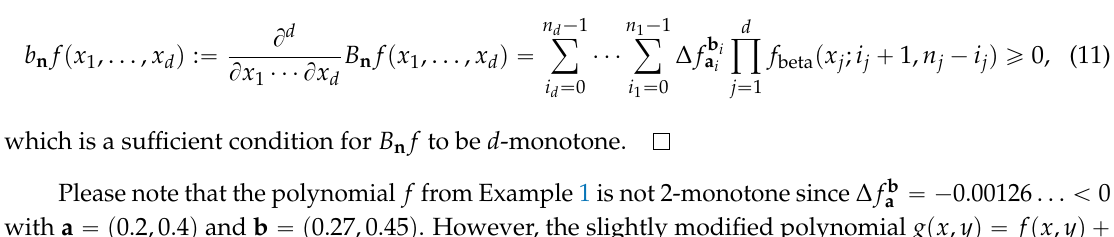
for the modified polynomial g i